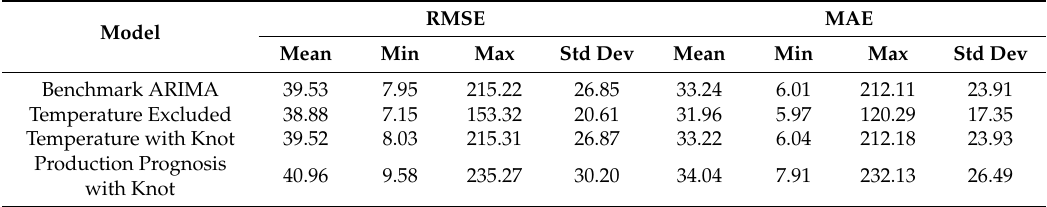
Table 5. Error values and variables excluded for